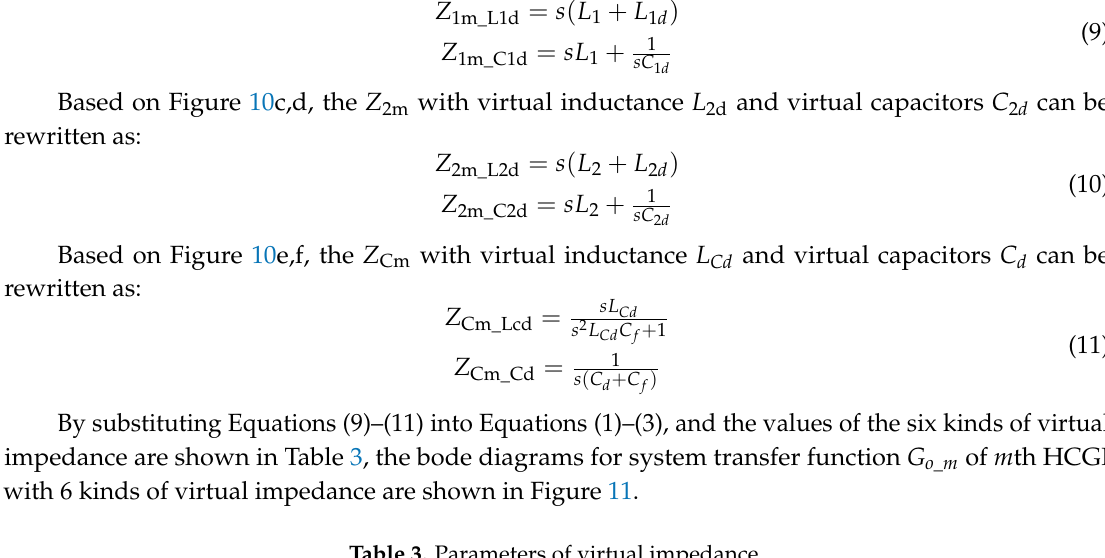
Figure 10. Virtual impedance equivalent circuits of actual LCL filter. ( a ) L 1 d ; ( b ) C 1 d ; ( c ) L 2 d ; ( d ) C 2 d ; ( e ) L Cd ; ( f ) C d .